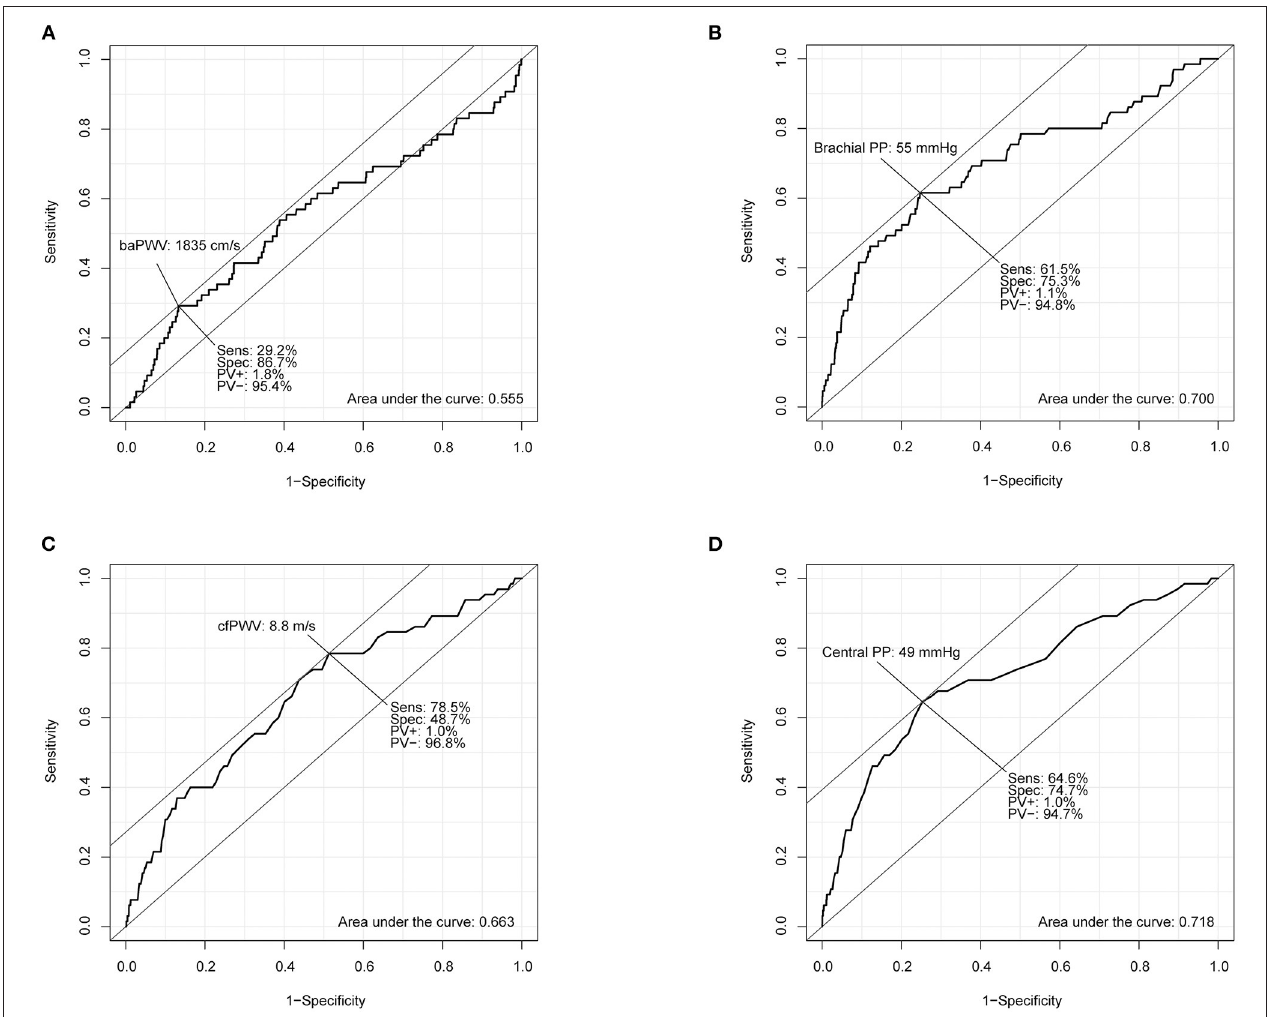
FIGURE 1 | Receiver operating characteristic curve analyses of brachial-ankle pulse wave velocity (baPWV; A ), brachial pulse pressure (brachial PP; B ), carotid-femoral pulse wave velocity (cfPWV; C ), and central pulse pressure (central PP; D ) for predicting incident heart